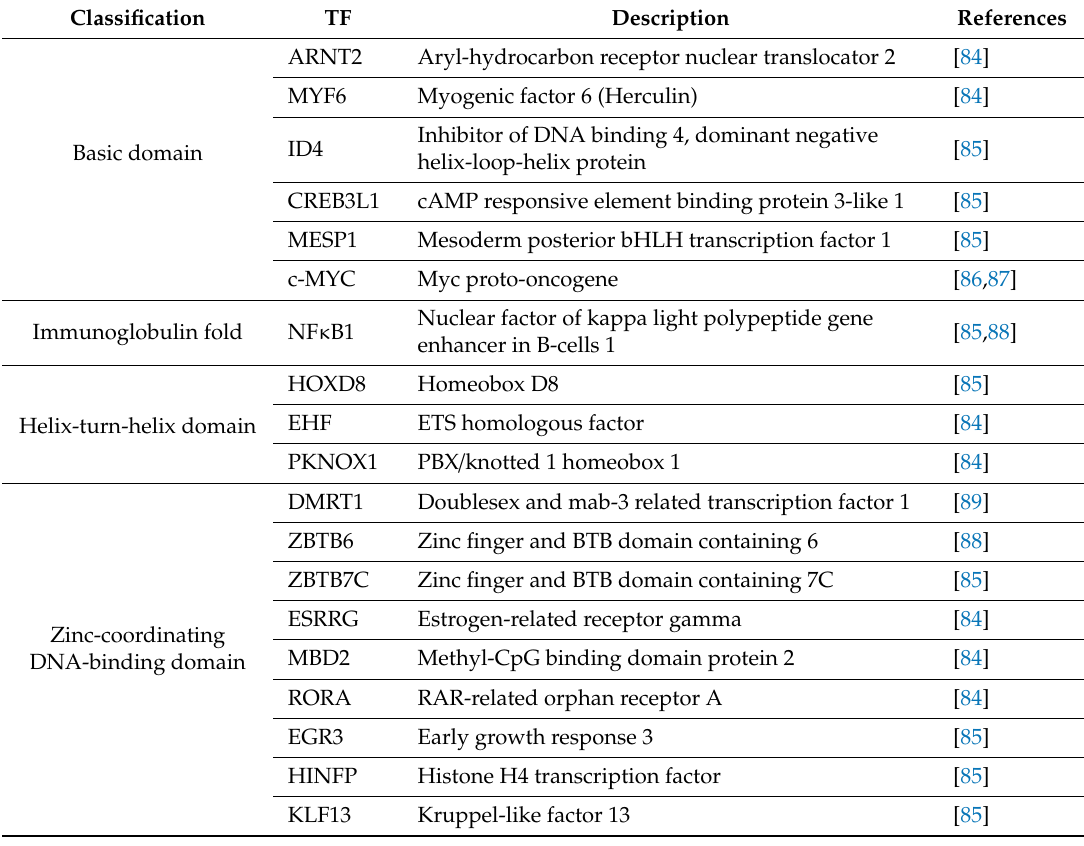
Table 2. Experimentally validated transcription factors that regulate the transcription of human GRINA by the RNA polymerase II (value: 0.0001), according to the TF2DNA database [82].